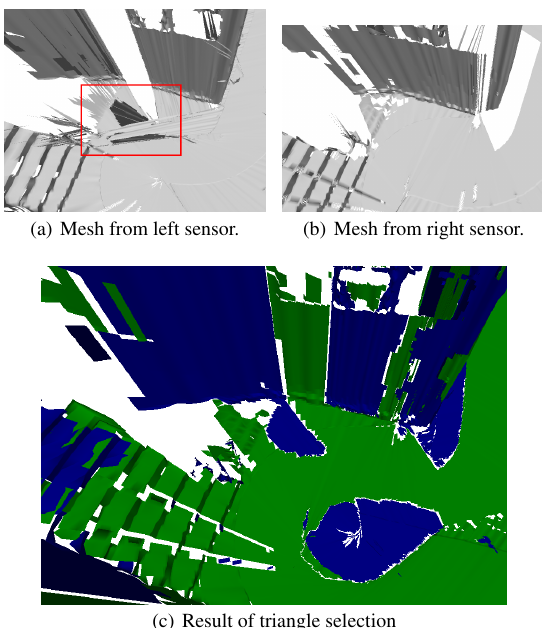
Figure 11. An example of triangle selection. The left mesh is in , right mesh is in .